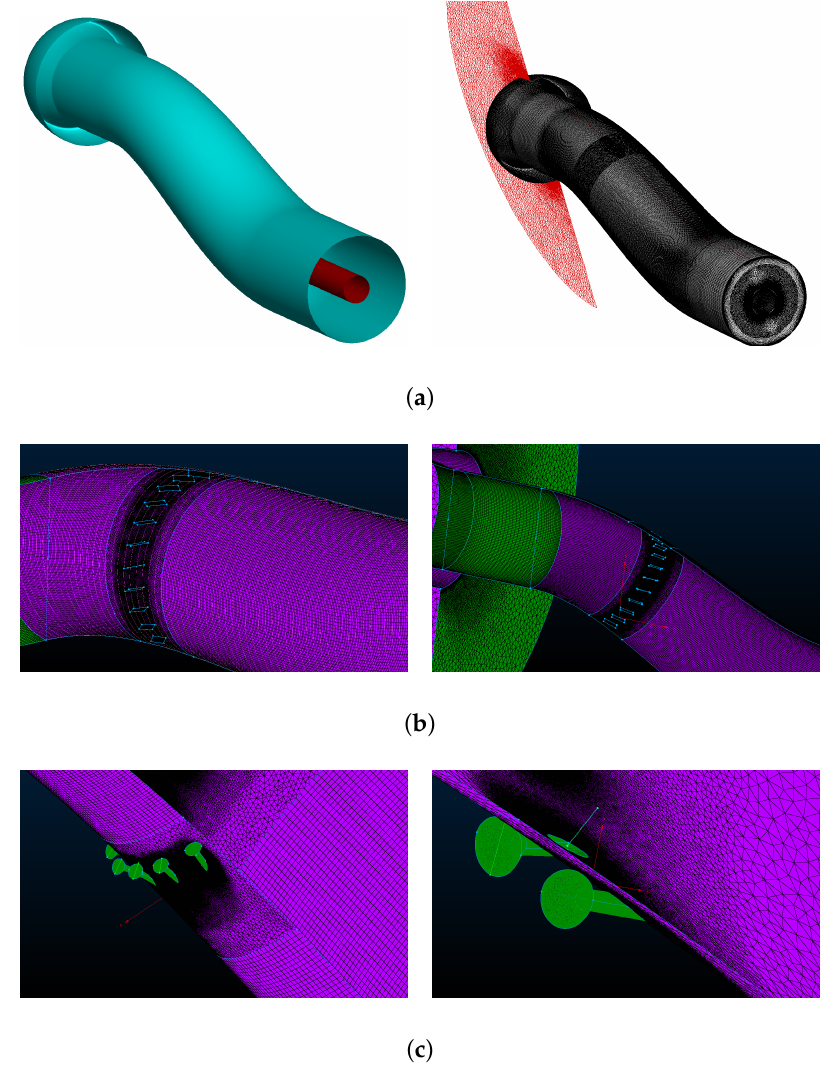
Figure 4. USAFA baseline intake model with vortex generator plates and jets. ( a ) USAFA baseline geometry and symmetry grid; ( b ) Vortex generator plates; ( c )